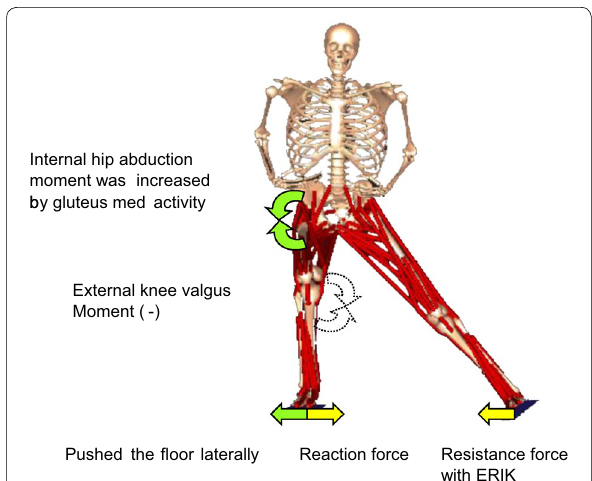
Fig. 1 Schematic image of the resistive leg reach exercise in CKC